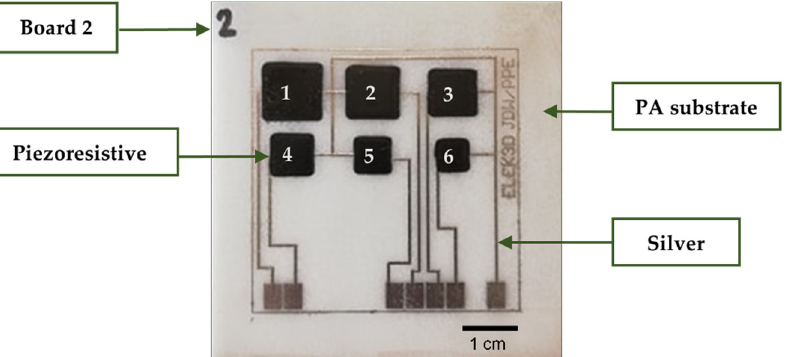
Figure 2. Arrangement of six piezoresistive pressure sensors printed on a PA substrate, with a sensing area decreasing from 100 to 25 mm 2 . The sensors are enumerated and ranked, ranging from 1 to 6, where “sensor PA_1” has the largest sensing area and is located in the upper left corner of the PA substrate.